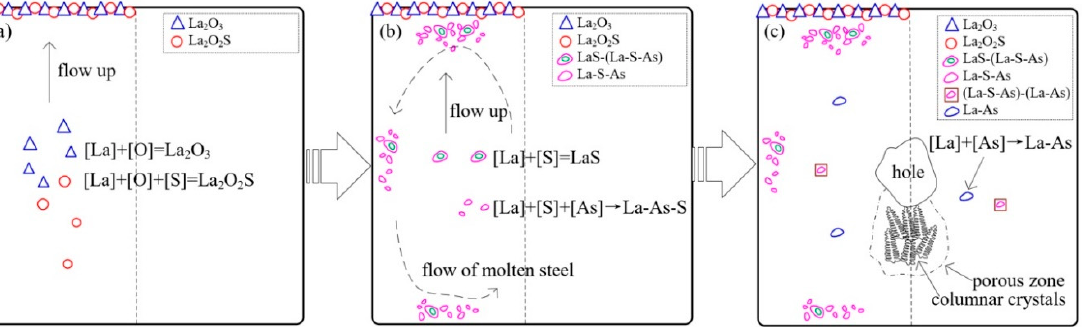
Figure 9. Distribution and formation process of inclusions. ( a ) Early period after adding lanthanum; ( b ) second stage after adding lanthanum; ( c ) during and after solidification. It is worthy of considerable attention that the La-S-As inclusions form in molten steel and distributes at the top surface within 3 mm and at the side and bottom surfaces within 1.5 mm. We